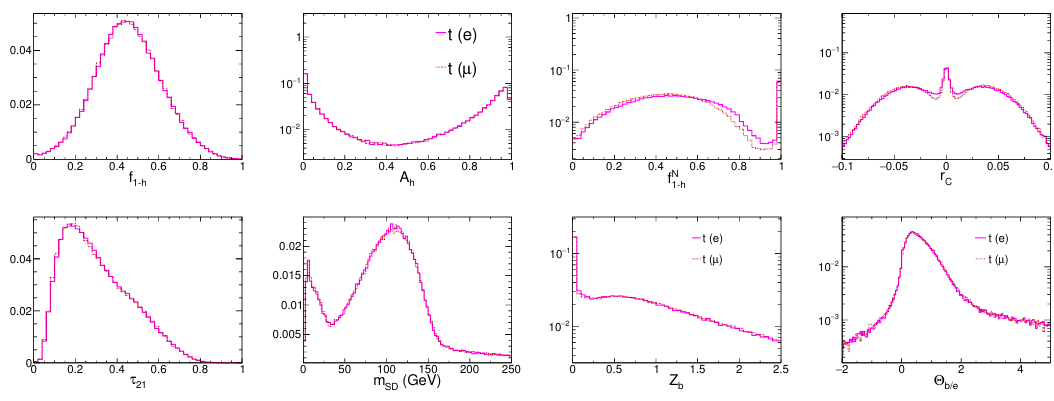
Figure 8 . Distribution of f 1-h , A h , f N